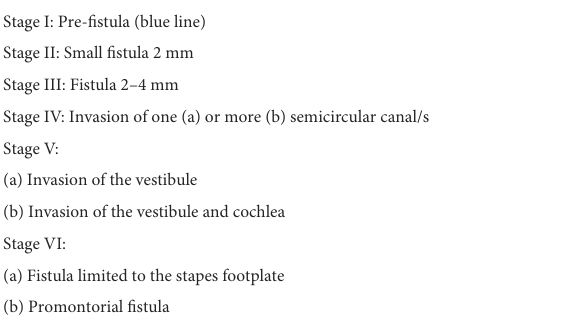
Stage I: Pre-fistula (blue line) Stage II: Small fistula 2 mm Stage III: Fistula 2–4